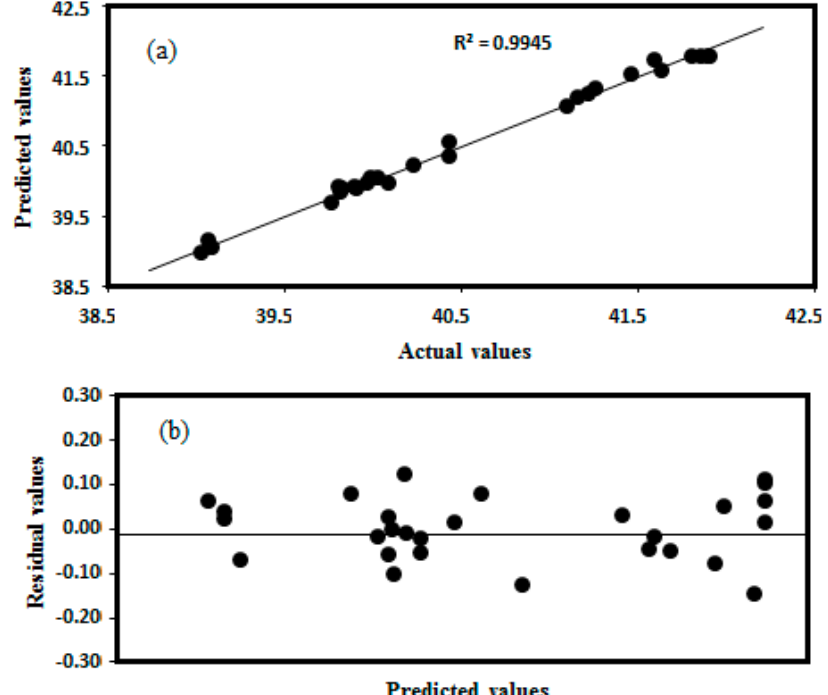
Figure 5. A plot of ( a ) actual versus predicted, and ( b ) predicted versus residual values to estimate the accuracy of the regression model.